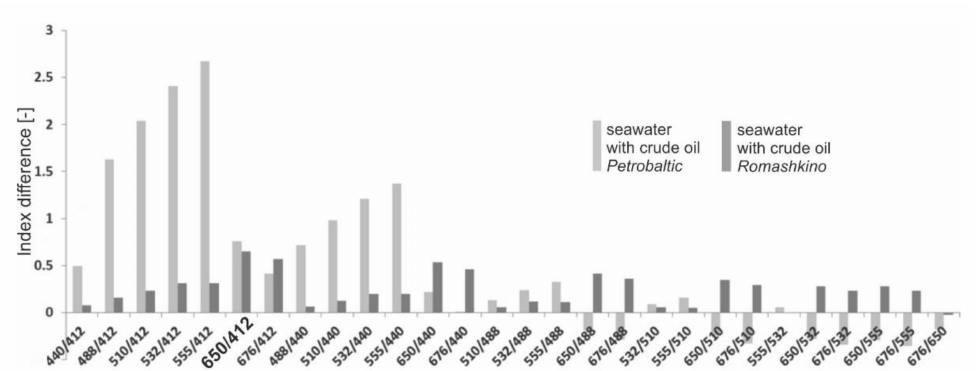
Figure 4. Differences between the values of the spectral indices of water contaminated by dispersed oil and the values of the indices of oil-free water contamination for a wind-induced rough sea surface (2